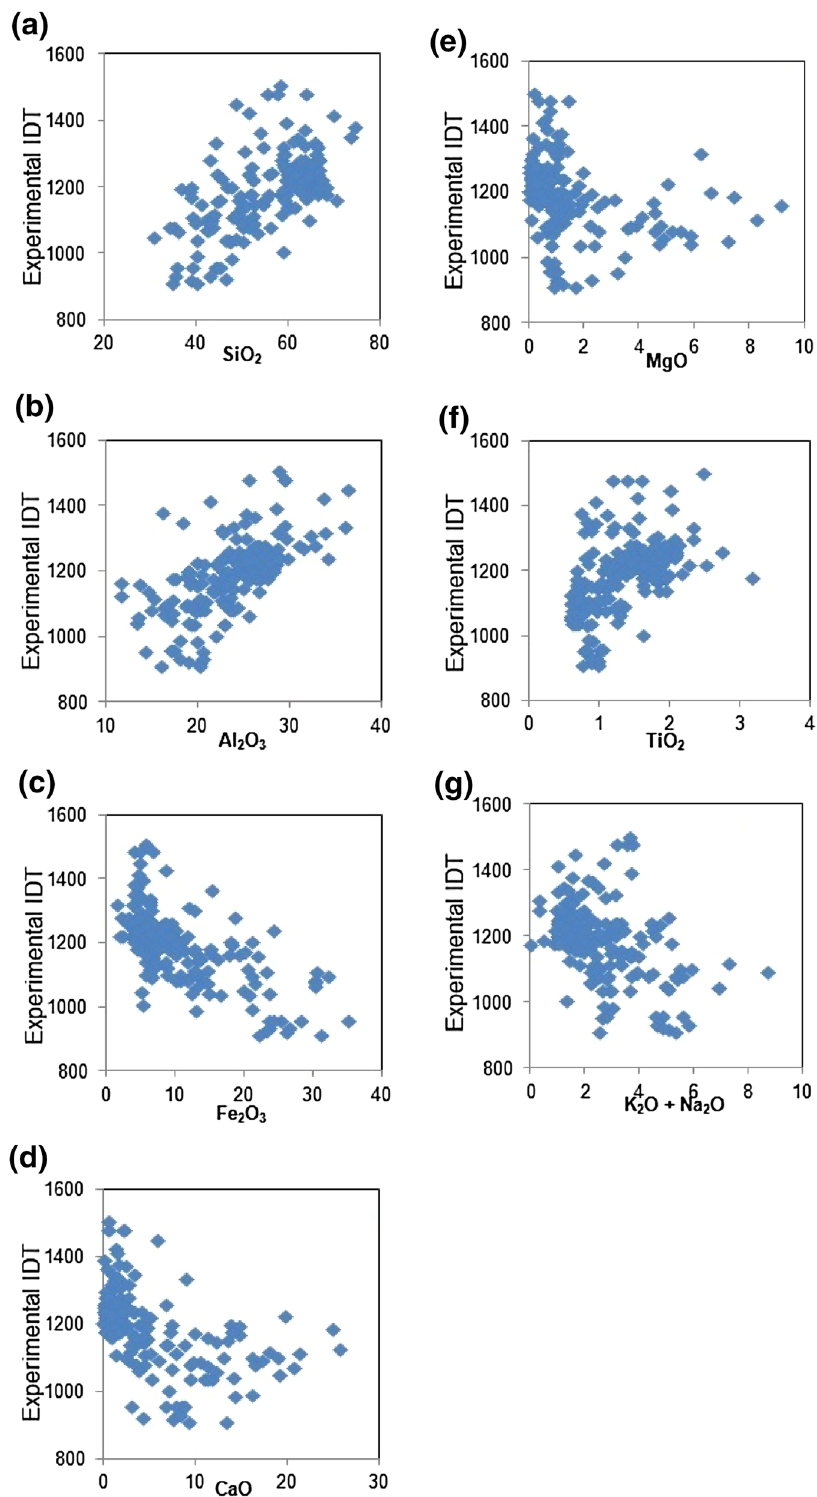
Fig. 1 Cross-plots of weight percentages (wt%) of individual metal oxides versus IDT